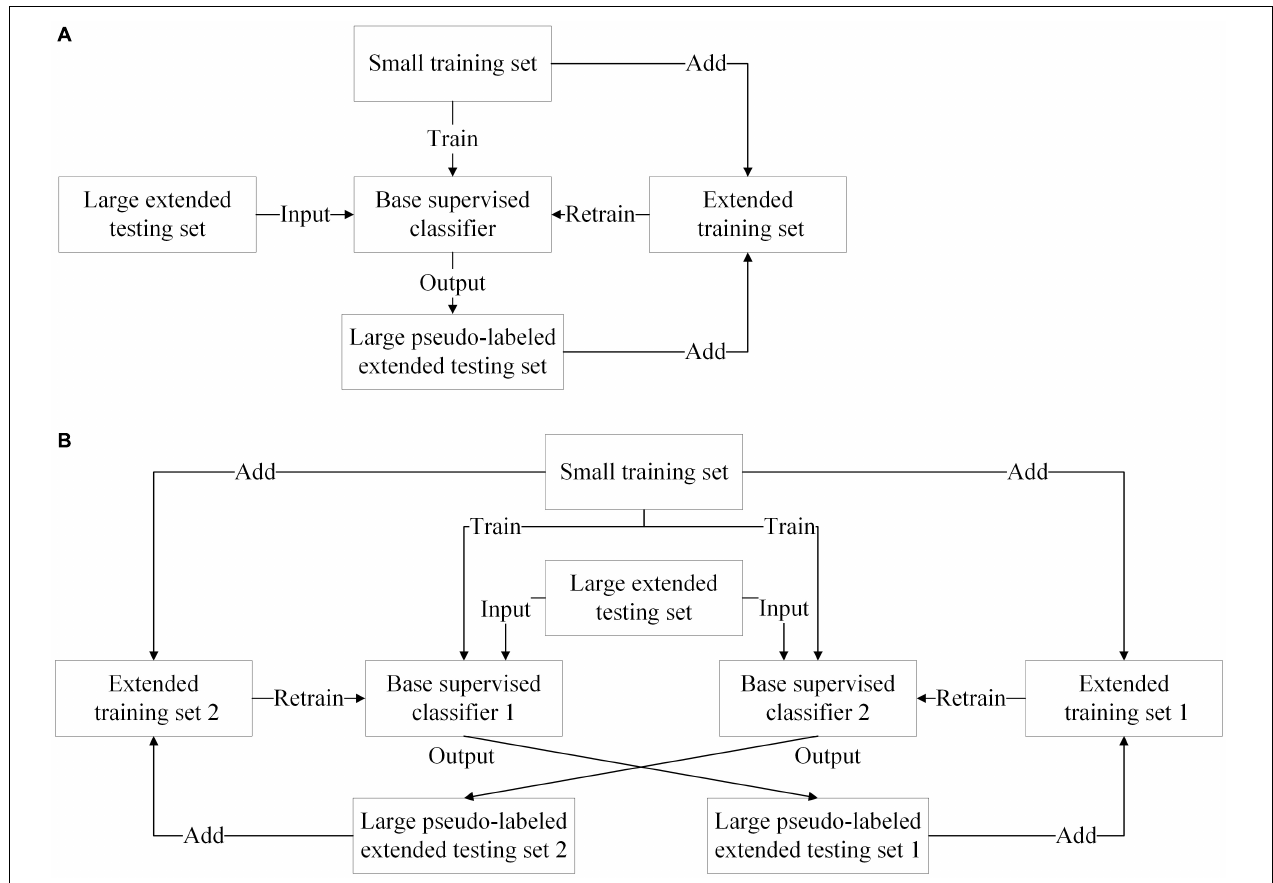
FIGURE 4 | Self-training and co-training models. (A) The framework of self-training model. ( B ) The framework of co-training